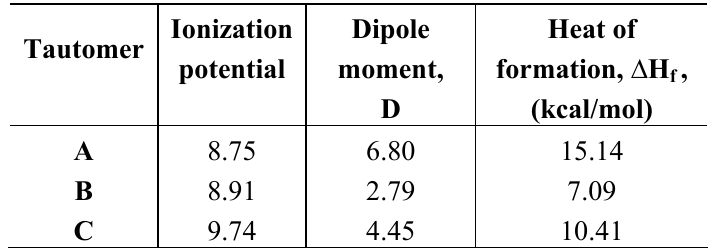
Table 1. The Heat of formation ( ∆ H ), Dipole moments and Ionization potentials for f tautomeric forms (A-C) of compound 1 , calculated by AM1 in gas phase ( ε